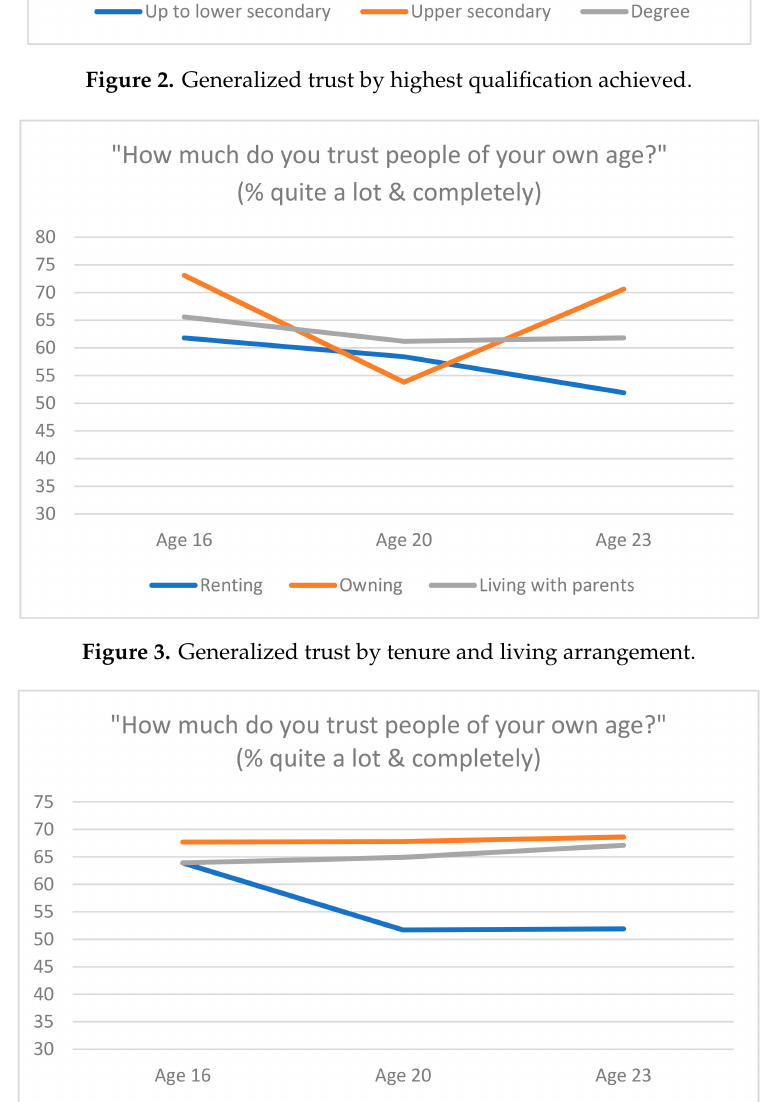
Figure 4. Generalized trust by active civic